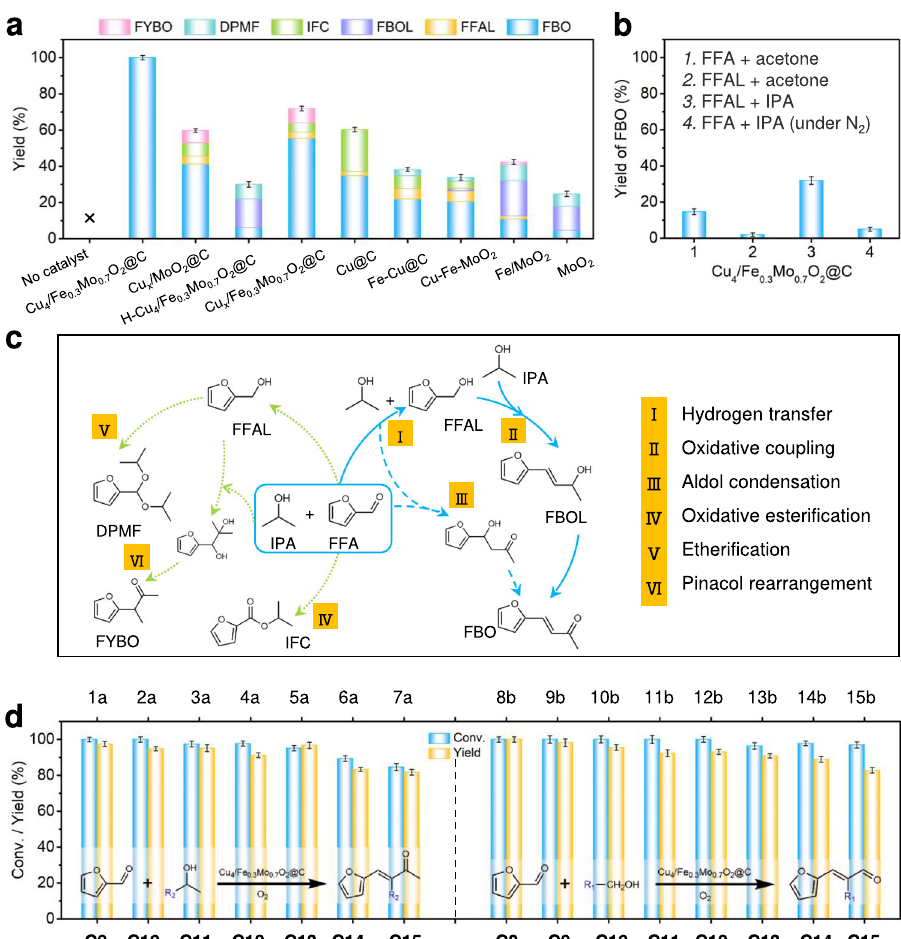
Fig. 5 Catalytic performance of Cu 4 /Fe 0.3 Mo 0.7 O 2 @C. a Oxidative coupling of FFA with IPA into FBO over different catalysts. Reaction conditions: FFA (0.5 mmol), catalysts (Cu, 3.6 mol%), K 2 CO 3 (0.1 mmol), IPA (5 mL), O 2 (2 bar), 120 °C, 16 h. Conversion and yield were determined by GC-MS. For the control catalysts without Cu species, the catalyst usage is 0.03 g. b Control experiments using FFA/FFAL and/or IPA/acetone as substrates over Cu 4 / Fe 0.3 Mo 0.7 O 2 @C. c Proposed reaction routes and possible by-products. d Oxidative coupling of FFA with secondary and primary alcohols (1a-7a, 8b-15b) into C 8 ~C 15 aviation biofuel intermediates over Cu 4 /Fe 0.3 Mo 0.7 O 2 @C. The error bars represent standard deviation based on three